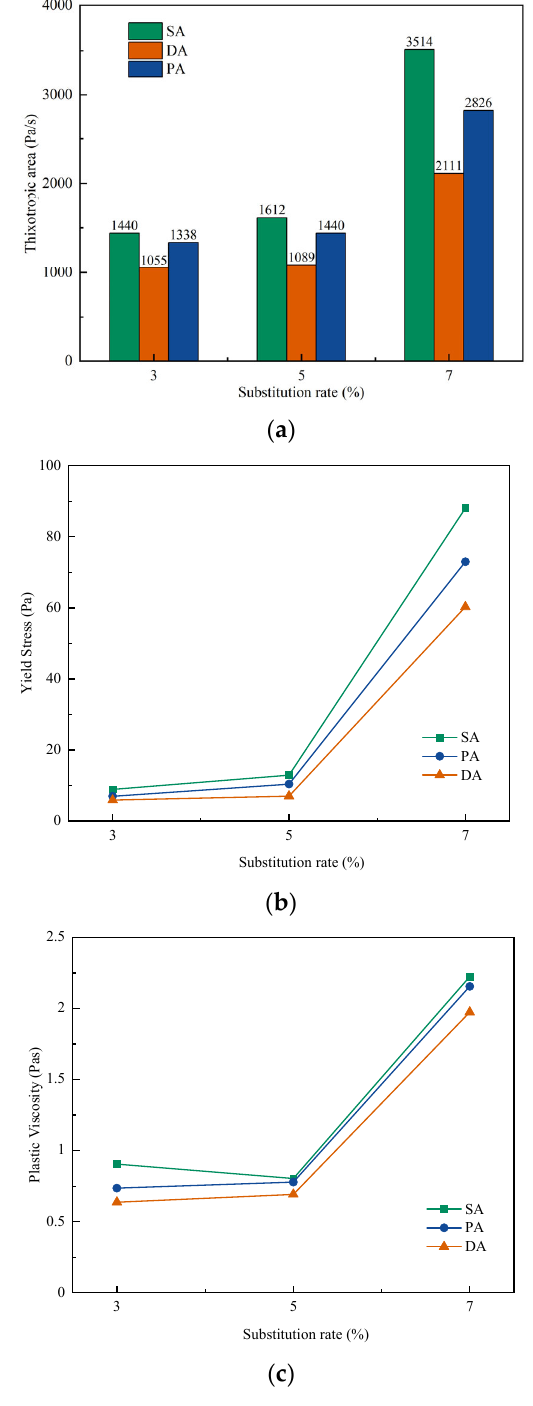
Figure 3. Rheological behaviour of cement pastes with PCE and PR under the different substitution rate of Na ‐ Mmt: ( a ) thixotropic area; ( b ) yield stress; ( c ) plastic viscosity.